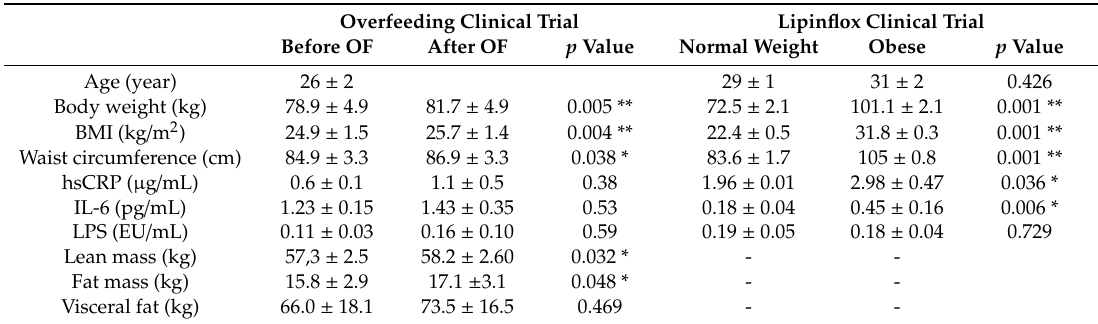
Table 1. Clinical characteristics of study subjects. Data are means ± SEM. Groups are compared